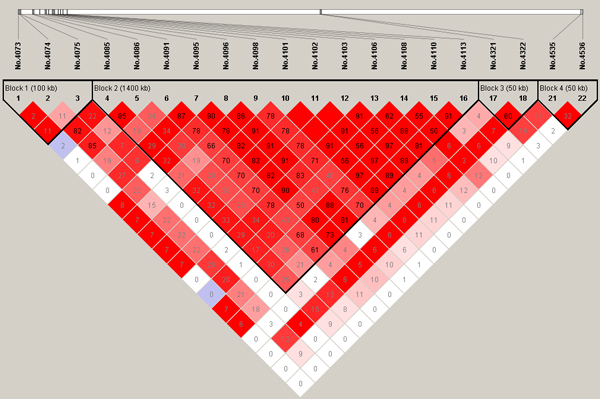
Linkage disequilibrium (LD) patterns for significant SNPs on chromosome 3. The true simulated QTN (No.3875 and No.4300, respectively) are also included in addition to the significant SNPs.